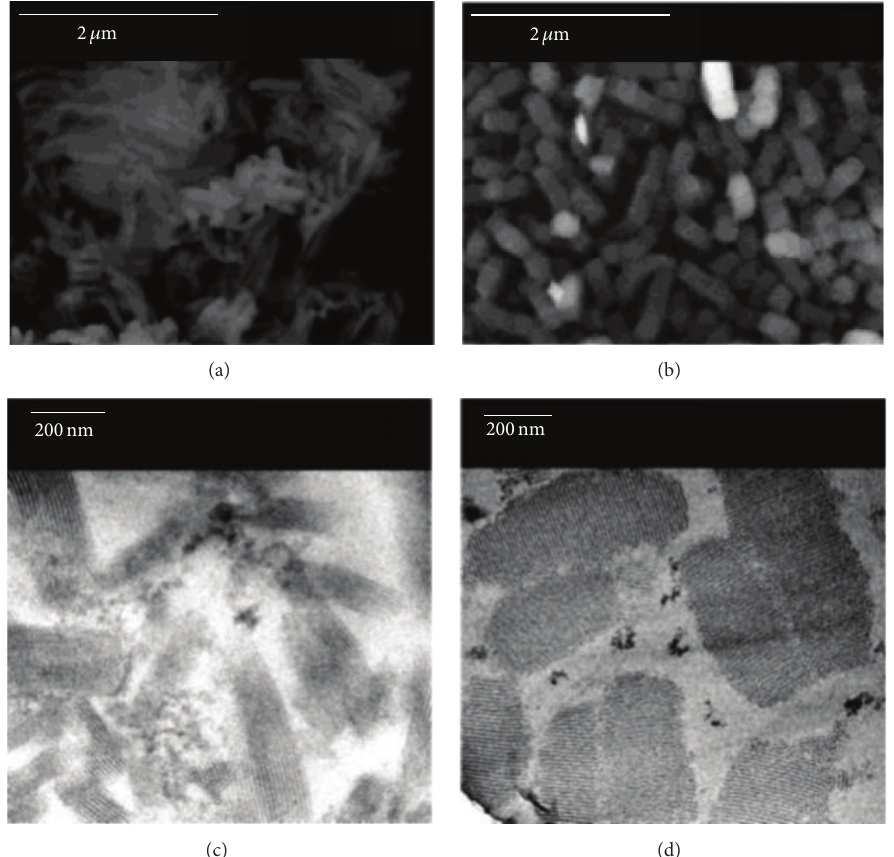
Figure 3: SEM images (a-b) and TEM images (c-d) of mesoporous silica SBA-15 synthesized at different weight ratios of decane to P123 in the presence of NH 4 F: (a) and (c) 0.4 : 1; (b) and (d) 5.8 :1. Reprinted with permission from [34]. Copyright (2004) American Chemical